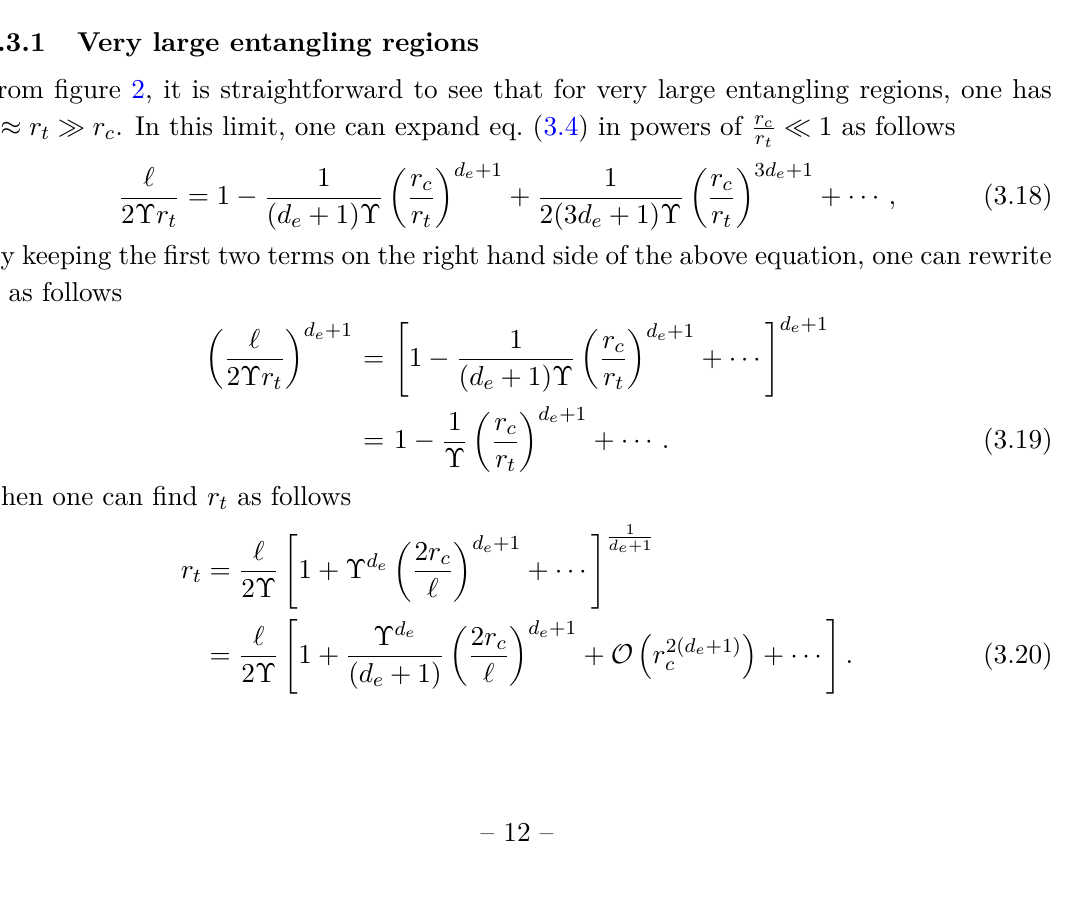
, where a = R d L d − 1 a 2 G N r θ F